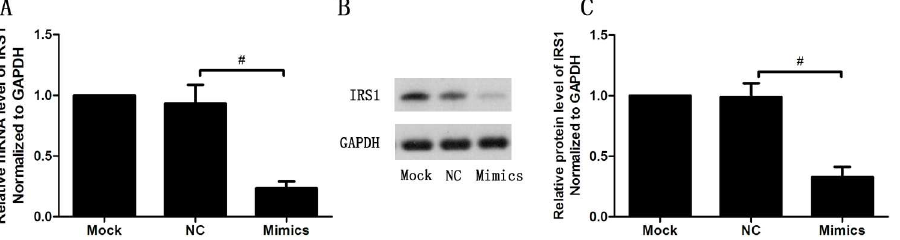
Fig 12. Effect of transfection with miR-139-5p mimics on IRS1 expression level in INS-1 cells measuredby qRT-PCR (A) and Western Blot (B and C) (n = 3,#p < 0.05). Cells were treated with Mock, NC (negative control) and Mimics for 24h. All experiments were performed in triplicate. Comparisons between groupswere by Student’s